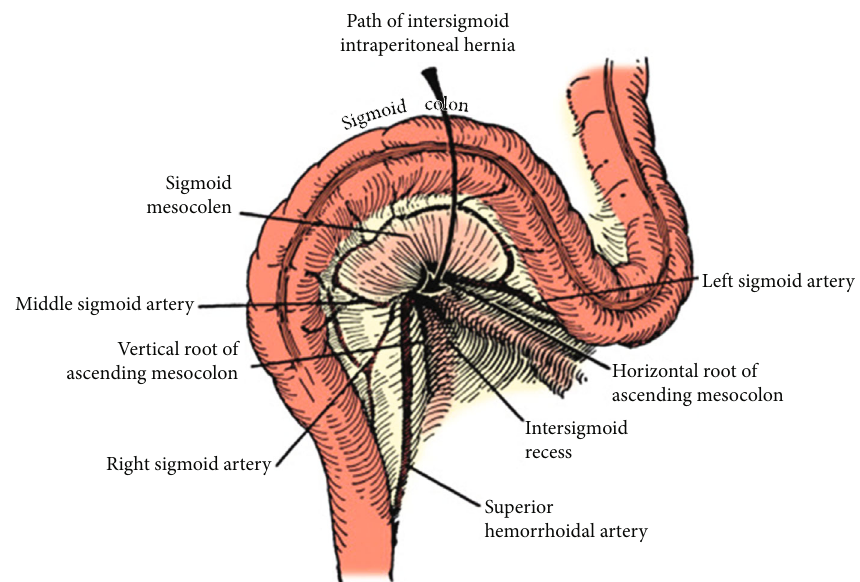
Figure 6: Intersigmoid hernia demonstration